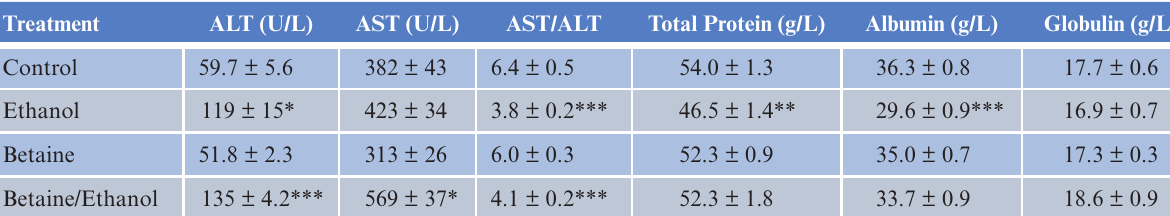
Table 2: The effect of ethanol and betaine on liver function.